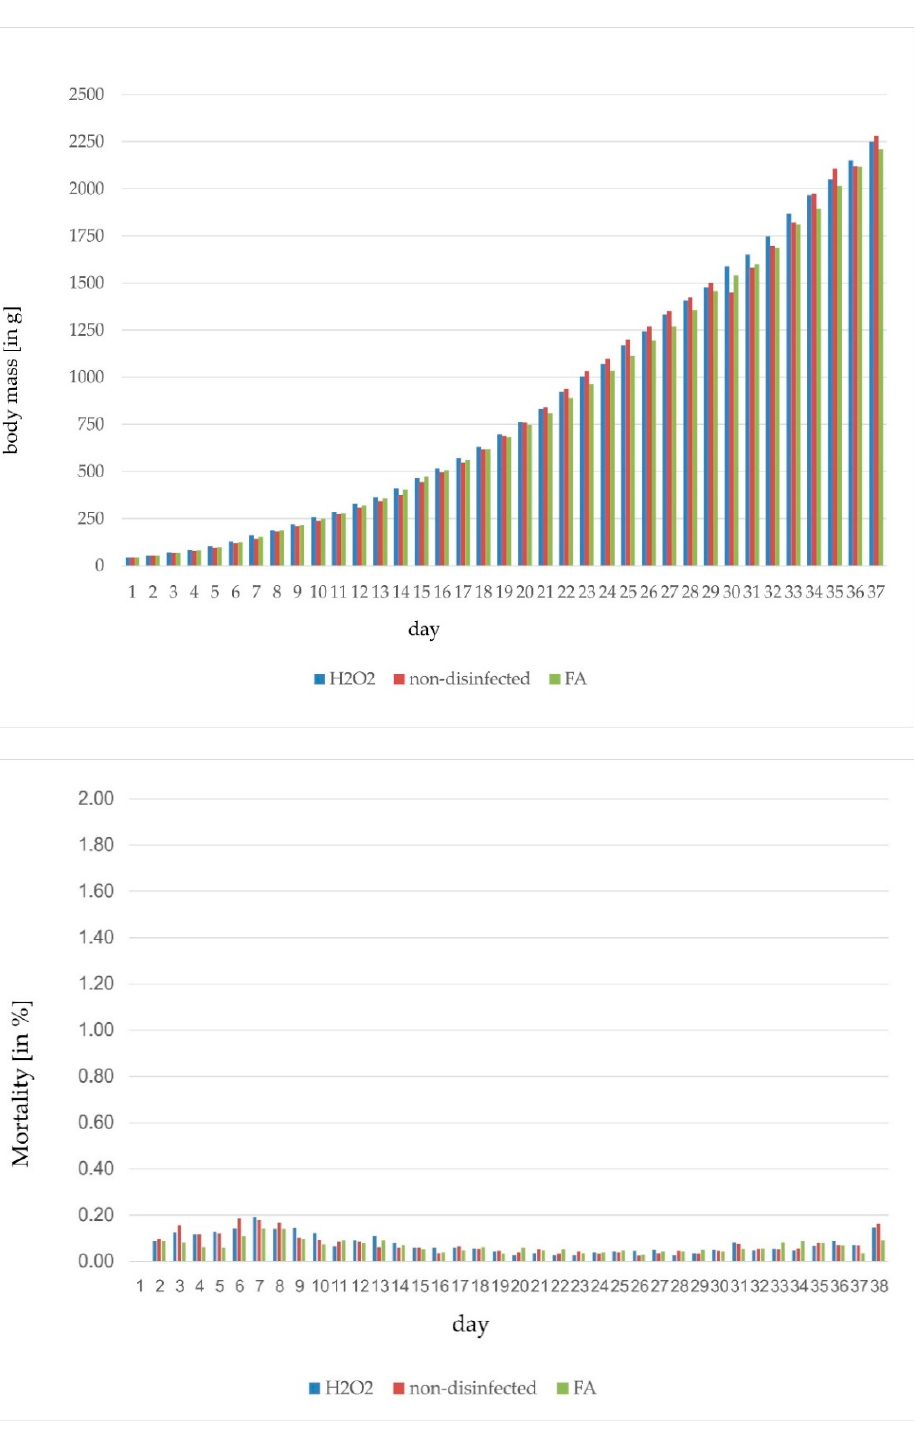
Figure 1. Body mass performance and daily mortality in trials 1 and 2. Presentation of the body mass performance [g] and daily mortality [%] comparing the H 2 O 2 treated group with the FA treated and non-disinfected group during the fattening period in trials 1 and 2. Trials 3 and 4 did not need antibiotic treatment over the entire fattening period. An augmented mortality, as in trials 1 and 2, could not be observed, so statistical evaluation was performed for all collected data. There were no significant differences concerning daily mortality and mean body mass development between all groups (see Figure 2).